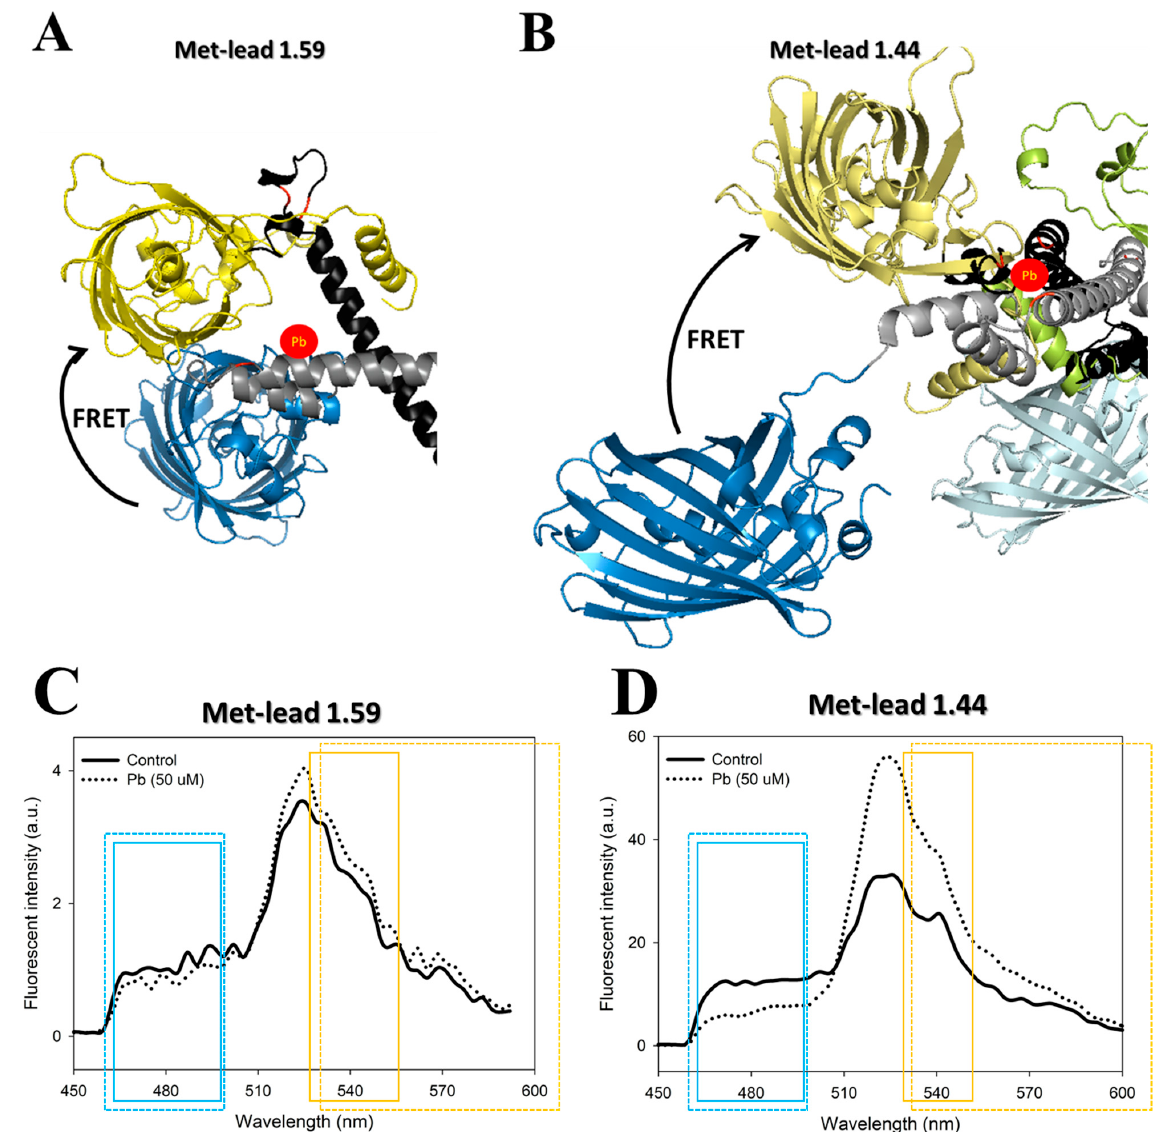
Figure 1. The simulated structure of FRET-based Met-lead Pb sensors. (A,B), The FRET pair of fluorescent proteins within Met-lead (( A ), version 1.59; ( B ), version 1.44) are depicted: ECFP (blue) and EYFP/Venus (yellow) led to FRET in the presence of the target (Pb, red circles), due to Pb binding by the sensing key residues (three red lines near Pb). This image was adapted from a previous report [26]. ( C , D ), Spectral comparisons of donor emission (ECFP) and acceptor emission (EYFP/Venus) between Met-lead 1.59 ( C ) and Met-lead 1.44 ( D ) using spectrum scans under 440 nm laser illumination (excitation source). More detailed information about the excitation and emission ranges of ECFP and EYFP/Venus is provided in Figure S1. The solid (in-cell FRET) and dashed (two-photon FRET) rectangles in C and D indicate the filter settings for the emission ranges of ECFP (blue) or EYFP/Venus (yellow). The spectral data was adapted from a previous report [23].